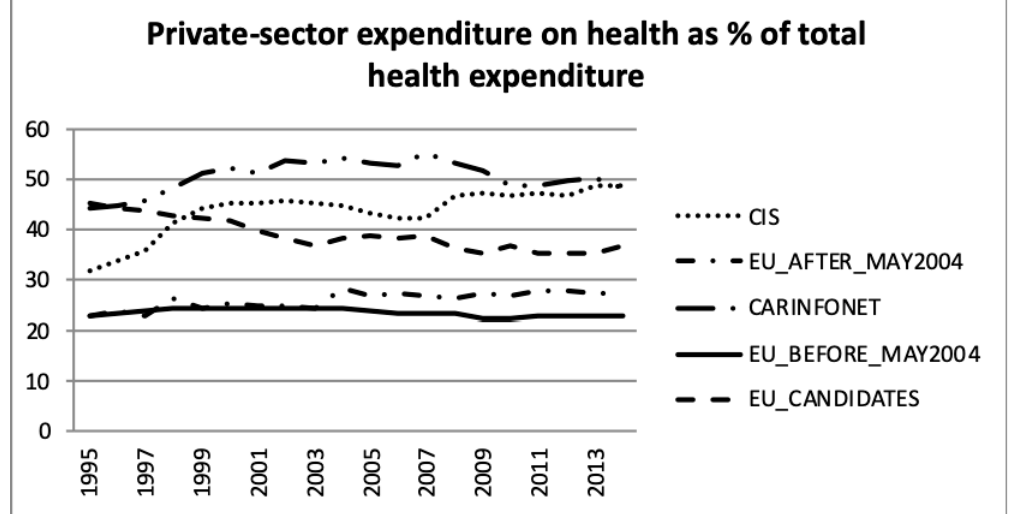
Figure 8. Private sector expenditure on health as a percentage of total health expenditure, the World Health Organisation estimates.